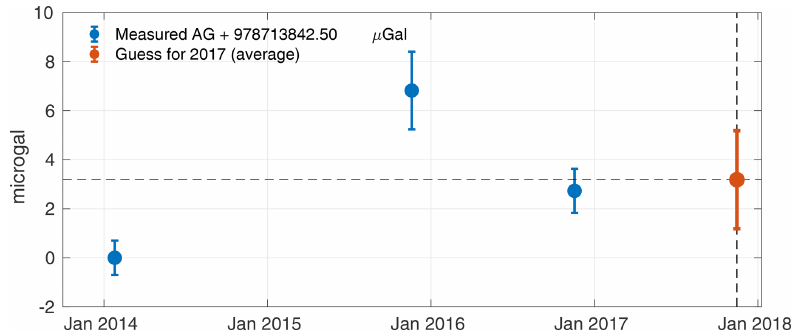
Figure 3. Absolute gravity values measured at AG06 in 2014 (25 January), 2015 (20 November) and 2016 (18 November). In 2017 (16 November), the absolute gravimeter suffered from a laser problem, and no measurement could be done. We thus assume that the value in 2017 is the average of the 2014, 2015 and 2016 values. These absolute gravity values are already corrected for tides, air pressure and polar motions but not for hydrology or vertical ground displacements. The error bars for the values in 2014, 2015 and 2016 combine the measurement uncertainty obtained during each gravity survey and the uncertainties due to the tides, air pressure and polar motion